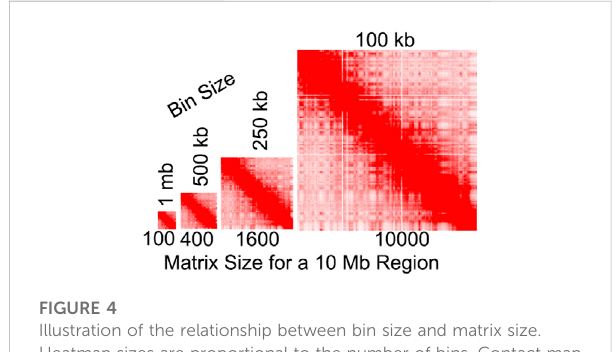
FIGURE 4 Illustration of the relationship between bin size and matrix